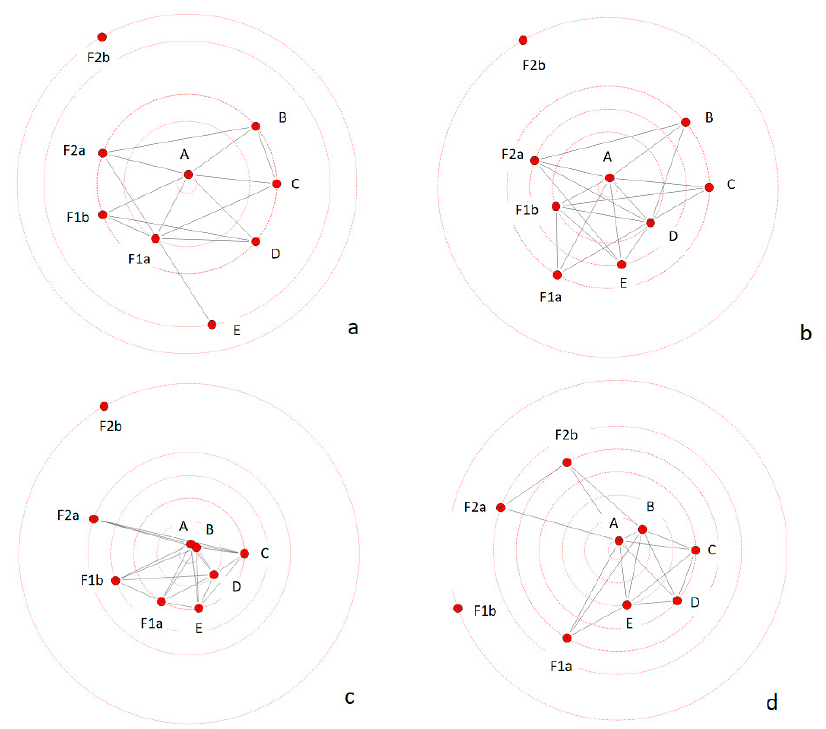
Figure 6. Radial representation of the networks showing the node centrality of concepts and sub-concepts per age group: ages 20–30